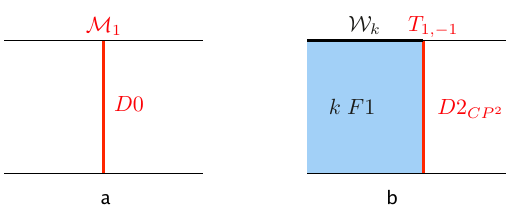
Figure 4 . A holographic description of (a) a dressed monopole, and (b) k Wilson lines being screened by an antisymmetric monopole in the U( N ) k